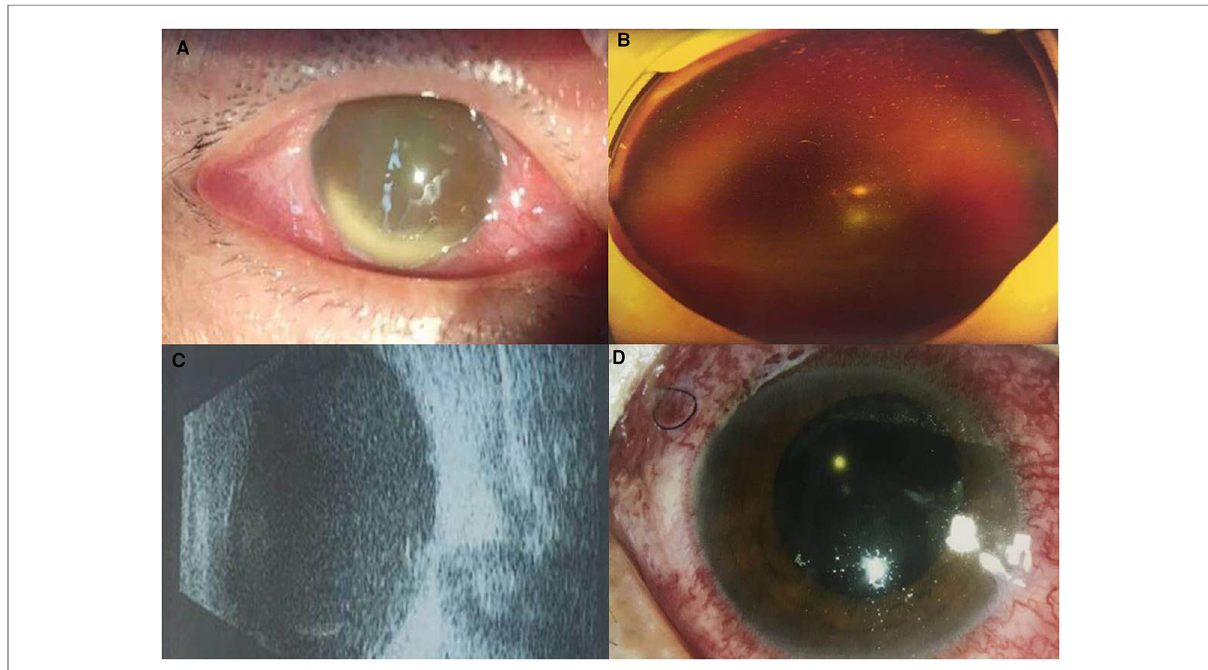
FIGURE 1 Ocular examination fi ndings before and after surgery: case 1. ( A ) Hyphema accounting for 1/4 of the height of the anterior chamber at the bottom before surgery. ( B ) Vitreous hemorrhage before surgery. ( C ) B-ultrasound scan showed vitreous exudation with a small amount of hemorrhage after surgery (massive high-density shadows located under the vitreous). ( D ) Cornea and aqueous humour were clearer after